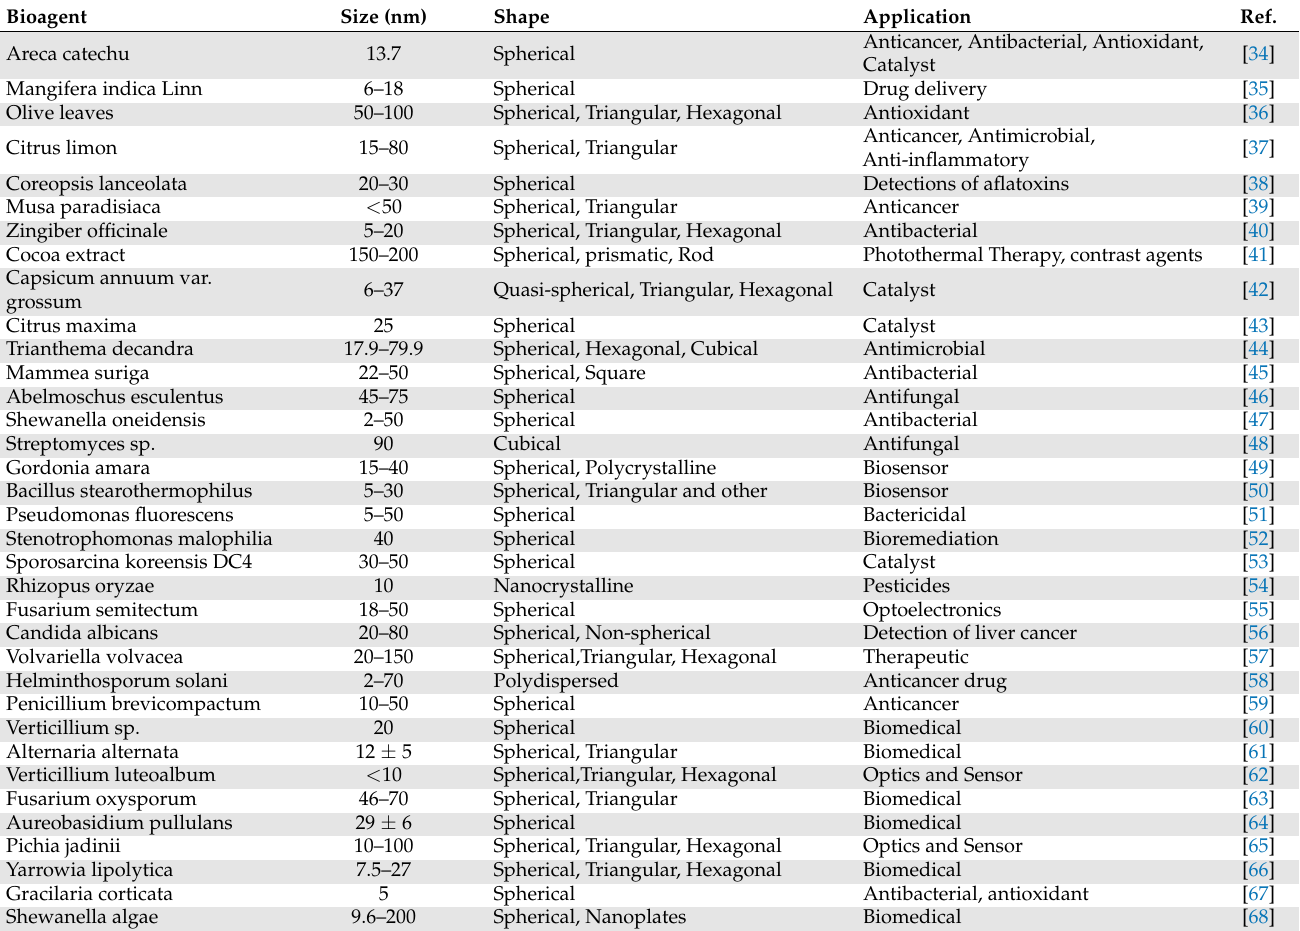
Table 1. Green synthesis of AuNPs using different bioagents and their